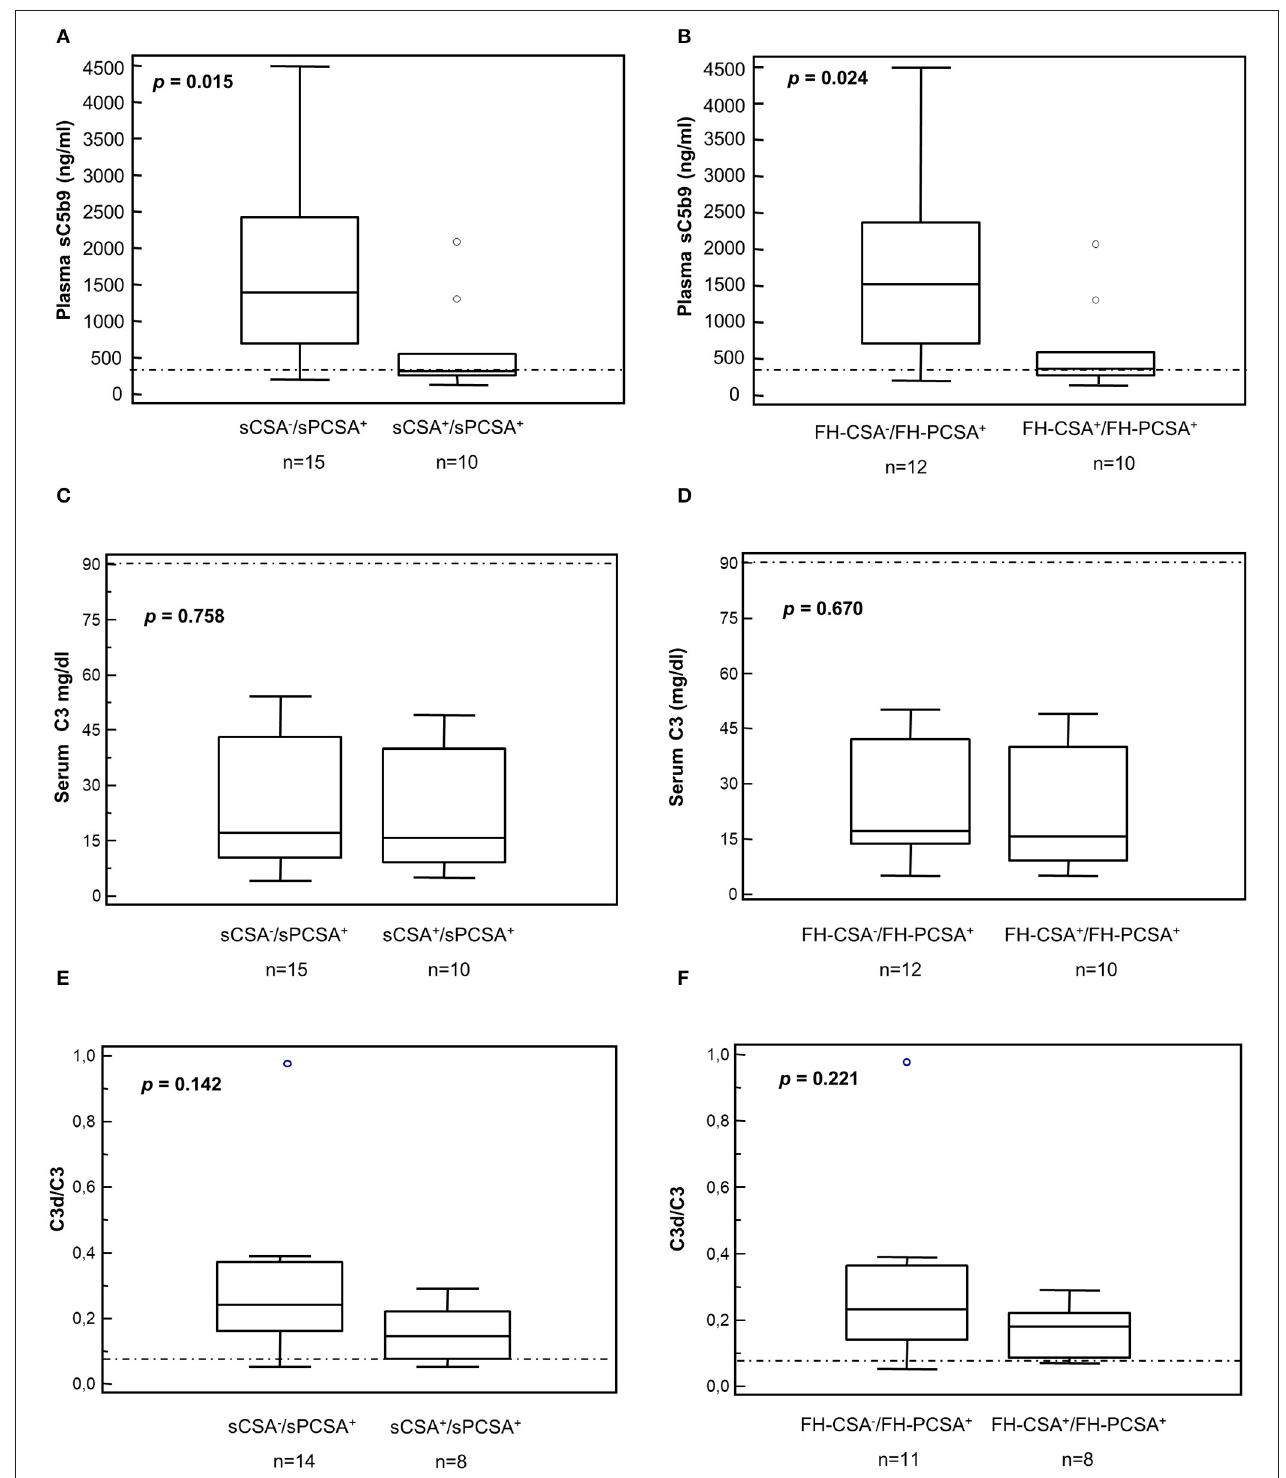
FIGURE 6 | Distribution of serum C3 and plasma sC5b-9 levels and plasma C3d/C3 ratios in patients according to results of C3 convertase stabilizing-activities in the absence or in the presence of properdin. (A,B) Plasma sC5b-9 levels. Box plots show that patients carrying C3NeFs with properdin-dependent C3 convertase-stabilizing activity against spontaneous ( A , sCSA − /sPCSA + ) and/or FH-mediated ( B , FH-CSA − /FH-PCSA + ) decay had higher plasma sC5b-9 levels than patients carrying C3NeF with properdin-independent activities ( A,B , sCSA + /sPCSA + and/or FH-CSA + /FH-PCSA + ). No significant difference was found in C3 levels and in C3d/C3 ratios (C–F) . The boxes represent the values from the 25 to 75th percentiles. The horizontal bars are the medians. Vertical lines are the 95% confidence intervals. Empty circles are values outside the 95% confidence intervals. The horizontal dashed lines show the upper limits of normal range of plasma sC5b-9 (A,B) and of the C3d/C3 ratio (E,F) , and the lower limit of serum C3 (C,D) in healthy subjects. Frontiers in Immunology | www.frontiersin.org